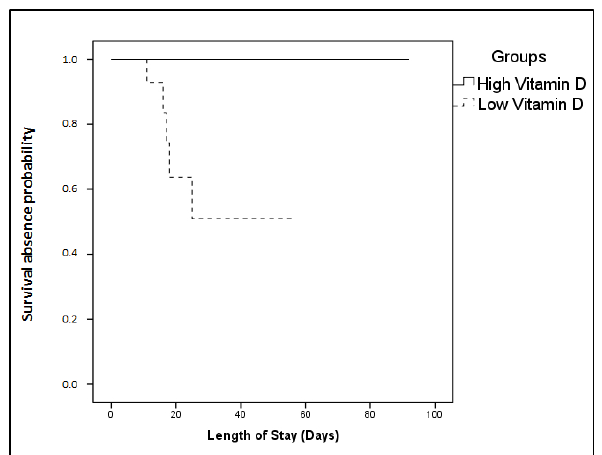
Figure 2. 25-hydroxyvitamin D on ICU admission and 28-day ICU mortality probability. Probability for 28-day mortality based on ICU admission 25(OH)D levels. The patient cohort was dichotomized above and below the median 25(OH)D value (15.2 ng/mL). Solid line: ≥15.2 ng/mL; dashed line: <15.2 ng/mL. The Kaplan–Meier method was used for 28-day ICU mortality probability estimation and the log-rank test for two group comparison. The probability of survival absence with time was significantly elevated in the low vitamin D group ( p = 0.01). All patients belonging to the high group survived, while all non-survivors belonged to the low